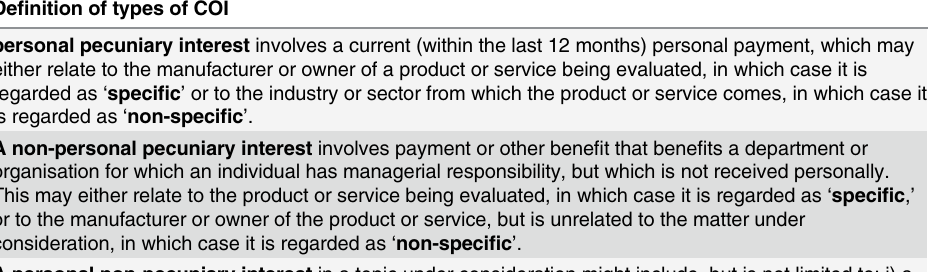
Table 1. Summary of NICE COI Code of Practice as it relates to clinical guidelines. De fi nition of types of